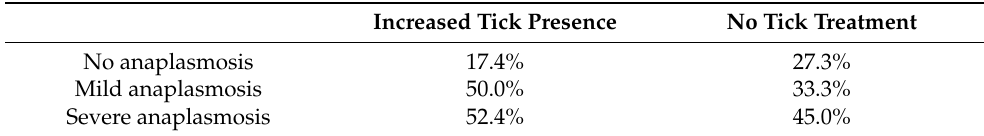
Table 5. Increase in the presence of ticks observed and absence of treatments against ticks in those farms that showed severe or mild anaplasmosis or absence of clinical signs.